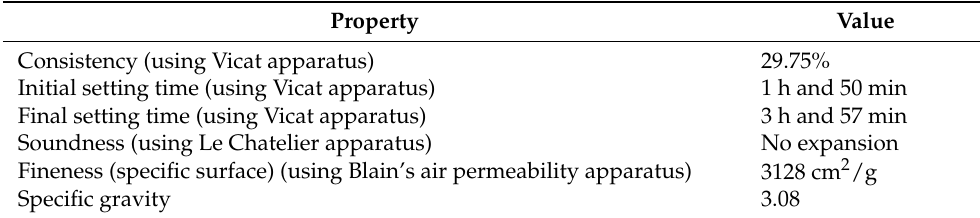
Table 1. Physical properties of ordinary Portland cement